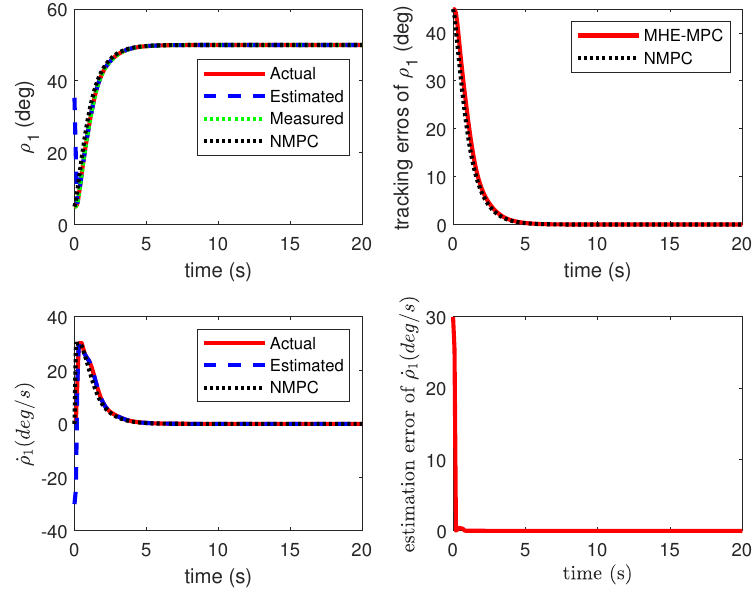
Figure 4. Case 1: state variables ρ 1 , ˙ ρ 1 and their tracking/estimation